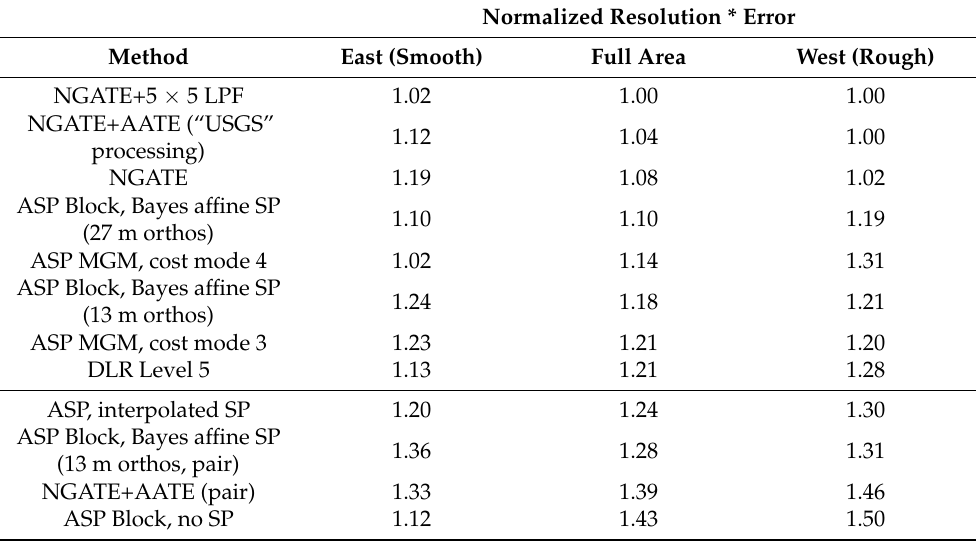
Table 5. Relative variation of the resolution-error product for Jezero